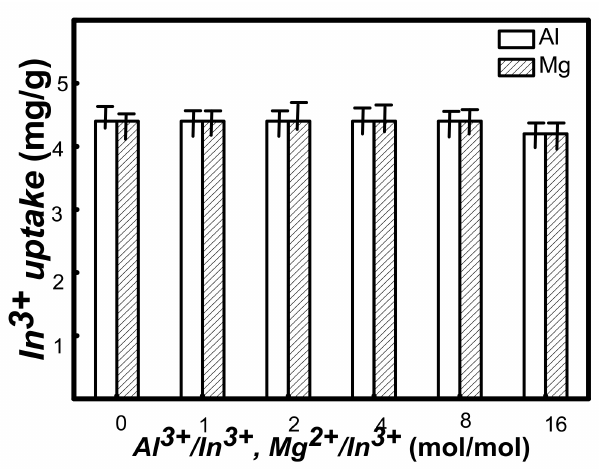
Figure 5. Effect of coexisting cationics of Al 3+ and Mg 2+ on the adsorption of In 3+ (pH = 3, m (UiO-66) = 20 mg, V (solution) = 40 mL, C 0 = 28 mg · L − 1 and T = 25 ◦ C).